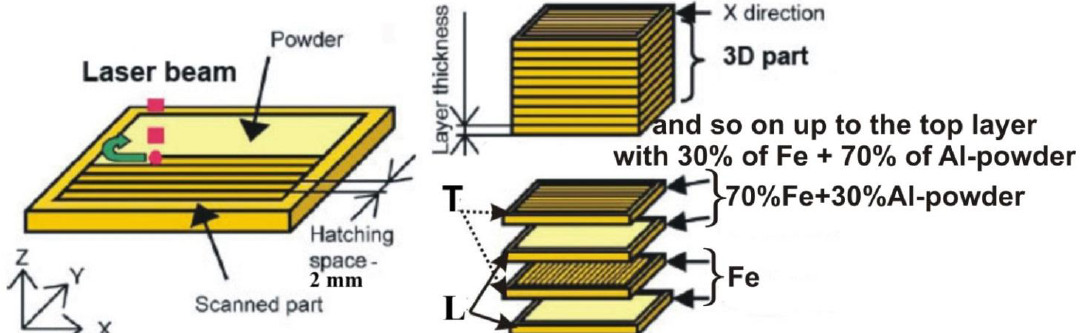
Figure 1. Schematic of the multi component graded structure fabrication by direct